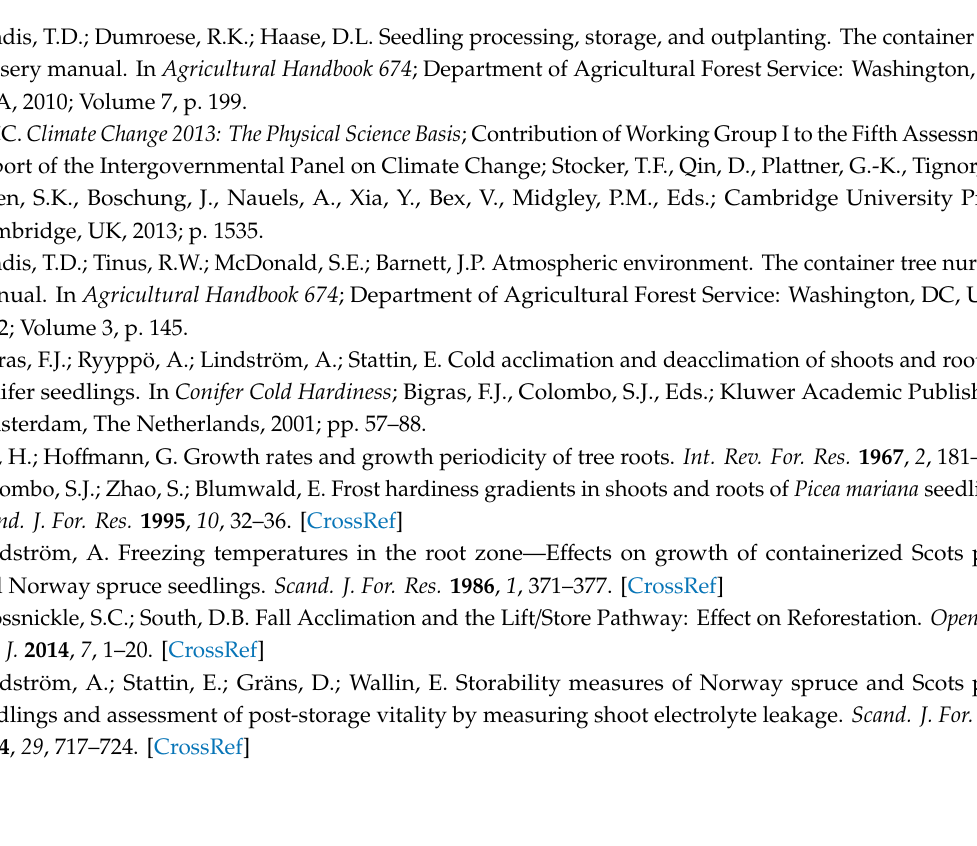
Table S1: Statistical significances of the e ff ects of treatment and date of storage on seedling attributes measured in Norway spruce seedlings that either received short-day treatment or did not. Figure S1: Height and stem diameter growth of control and short-day (SD)-treated Norway spruce seedlings after the second growing season in the field in 2014. Figure S2: Relationship between frost hardiness of needles and accumulation of chilling hours and day of year in Norway spruce seedlings in the data that were combined from five